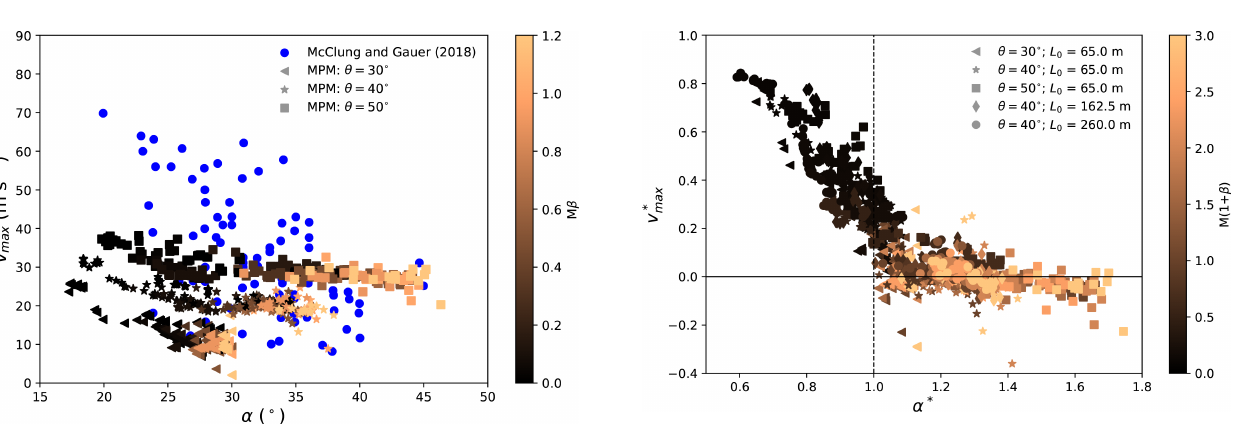
Figure 8. Evolution of the maximum velocity with α for varying slope angles θ .